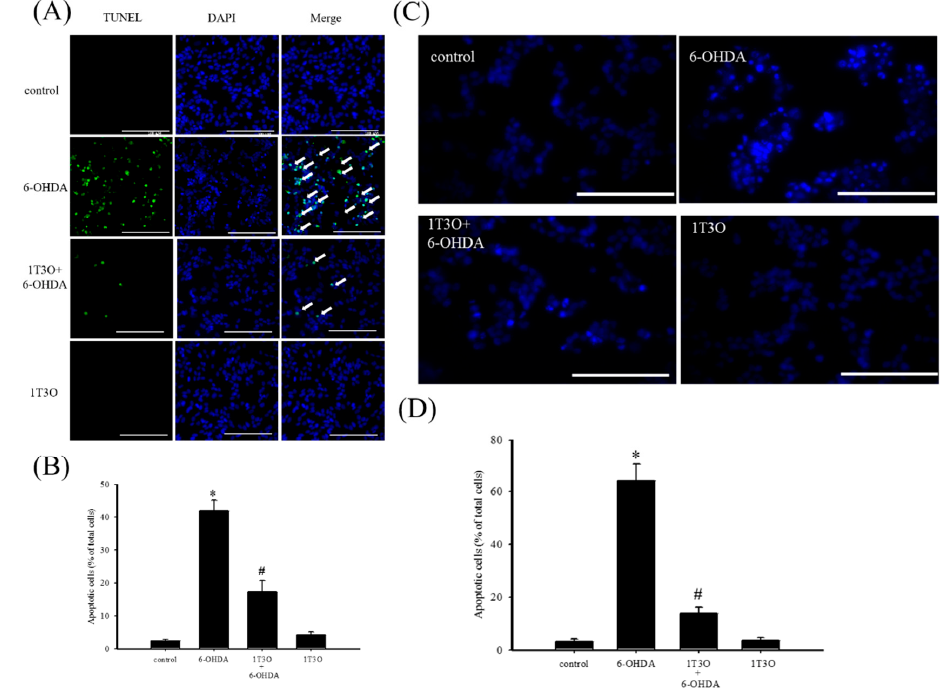
Figure 3. The effect of 1T3O on 6-OHDA-induced apoptosis in SH-SY5Y cells. ( A ) TUNEL stain